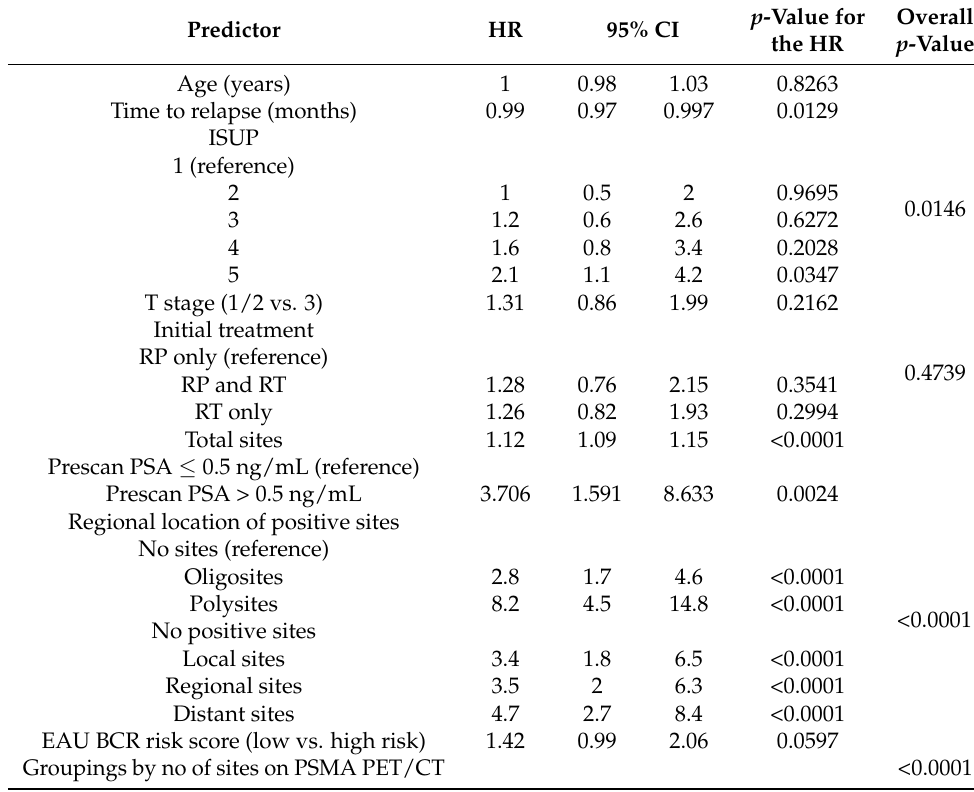
Table 3. Cox model of the individual predictors of overall survival for patients with PSA